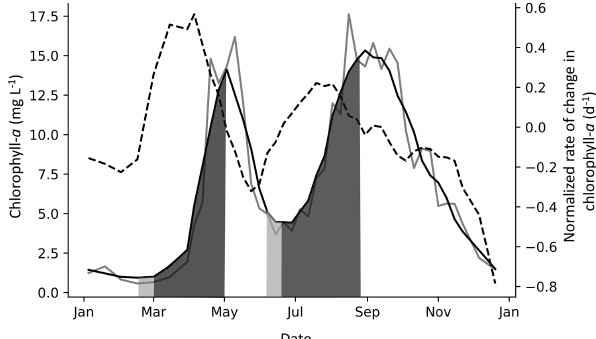
Figure 3. Example of spring and fall PCIs in Lake Windermere’s north basin in 1988. The solid grey line is the chlorophyll- a concen- tration (µgL − 1 ), and the solid black line is the chlorophyll- a con- centration smoothed with a Savitzky–Golay filter. The dashed line is the normalized rate of change in chlorophyll- a (NRCC) (d − 1 ), where the first derivative is divided by the smoothed chlorophyll- a concentration and is plotted using the right axis. The PCI begins when the NRCC surpasses a threshold of 0.4d − 1 , as shown in the first (spring) PCI, and ends when the NRCC turns negative, which is when the peak chlorophyll- a concentration is reached. When a peak is detected but the NRCC does not surpass a threshold of 0.4d − 1 , the PCI begins when the NRCC surpasses 0d − 1 , as shown in the second (fall) PCI. The PCI and pre-PCI (two weeks leading up to the PCI) are shown in dark and light grey shading,